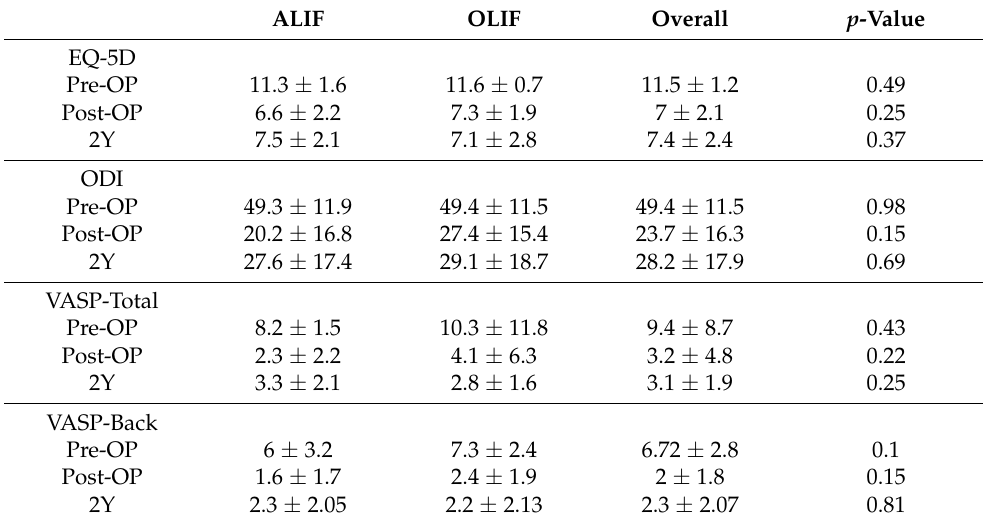
Table 3. Comparison of functional outcome of the study population stratified by lumbar interbody fusion